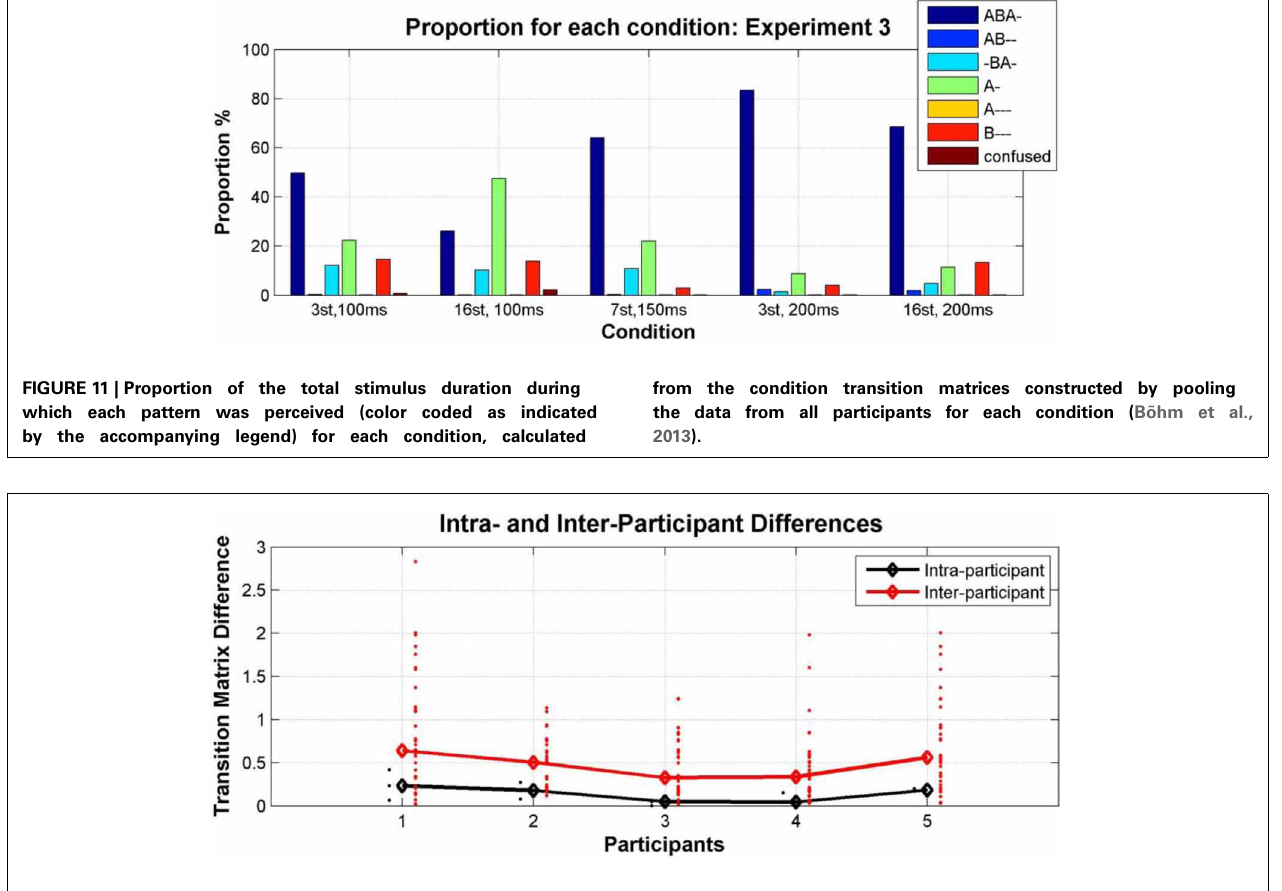
median—black diamonds, line), and differences between the transition matrices of each participant and those of all other participants (red dots; median—red diamonds,